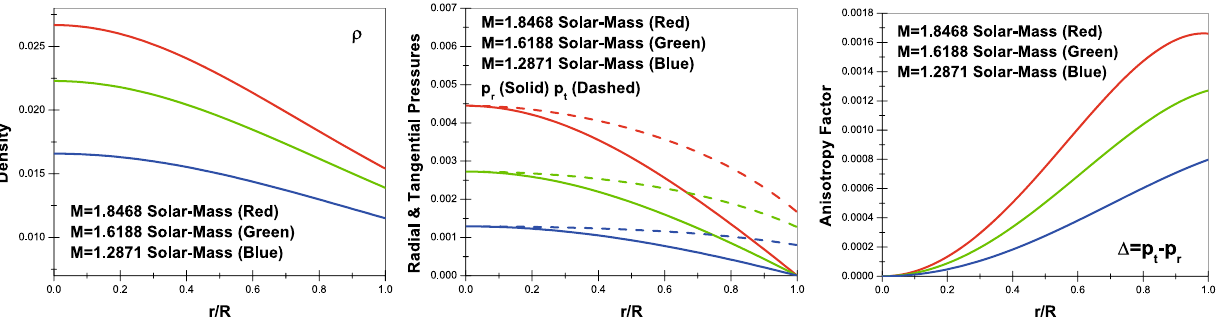
Fig. 2 Left Panel : The density ρ profile against the dimensionless radial coordinate r / R . Middle Panel : The radial p r and tangential p t pressures versus the dimensionless radial coordinate r / R . Right Panel : The anisotropy factor (cid:5) versus r / R . All these plots have been built by